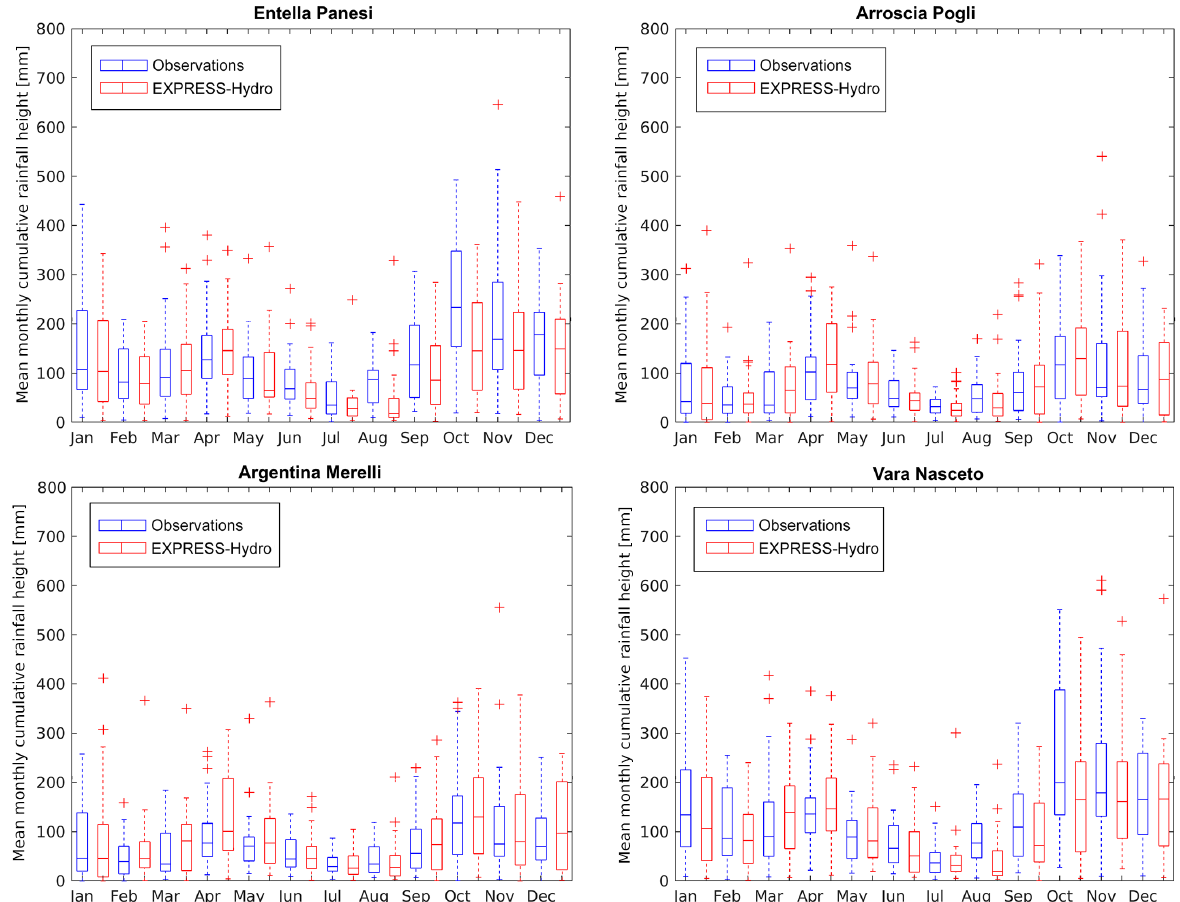
Figure 6. Box plot of monthly precipitation averaged at the basin scale for four test catchments. Blue box plots are built with observations while red ones are built with the EXPRESS-Hydro